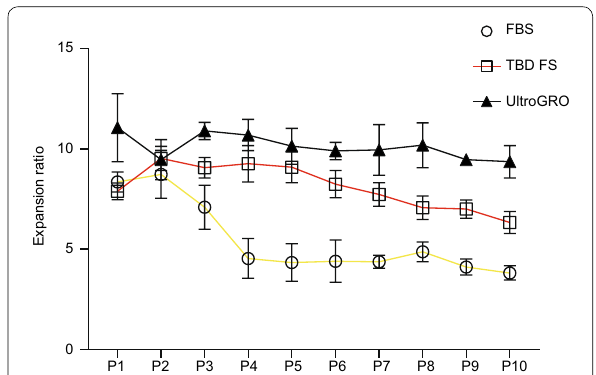
Fig. 3 The proliferation capacity of MSCs in the three groups. The proliferation ability of UC-MSCs in FBS, TBS FS, and UltraGRO group was measured by cell count. For all experiments, n donors/group, and data shown are mean